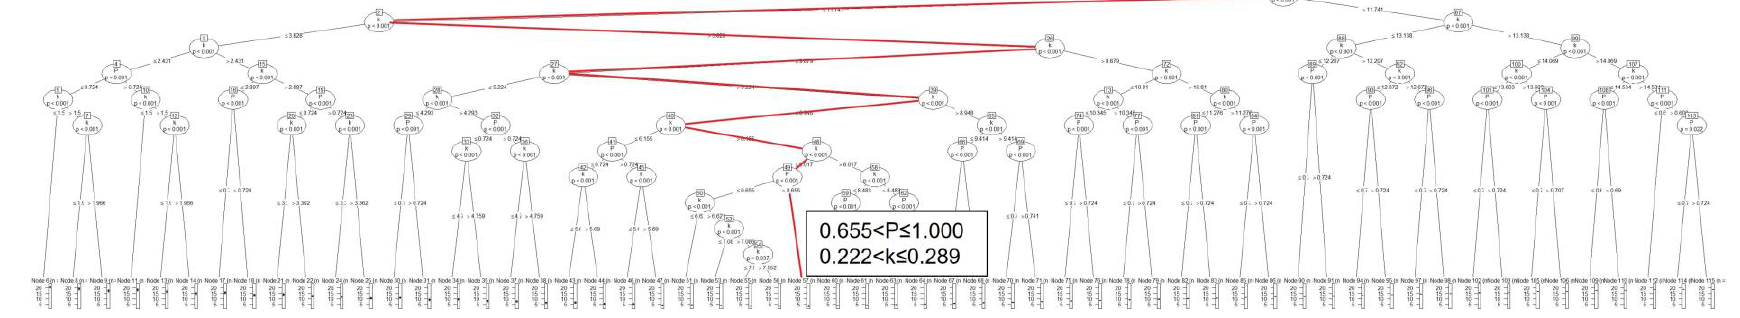
Figure 7. Influence profiles of P and k over the CV-RMSE for the PM2.5 decay scenario of Case I.